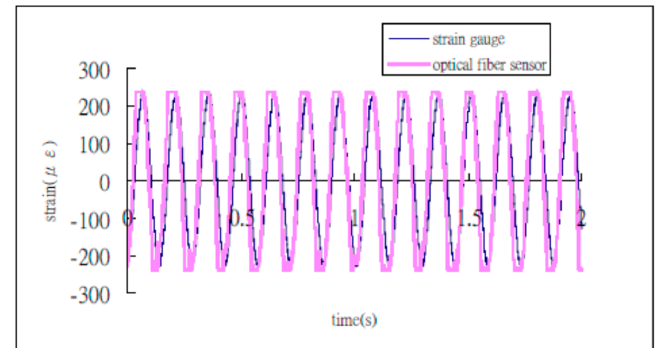
Figure 8 . Vibrational response of a cantilever beam subjected to single frequency base excitation .